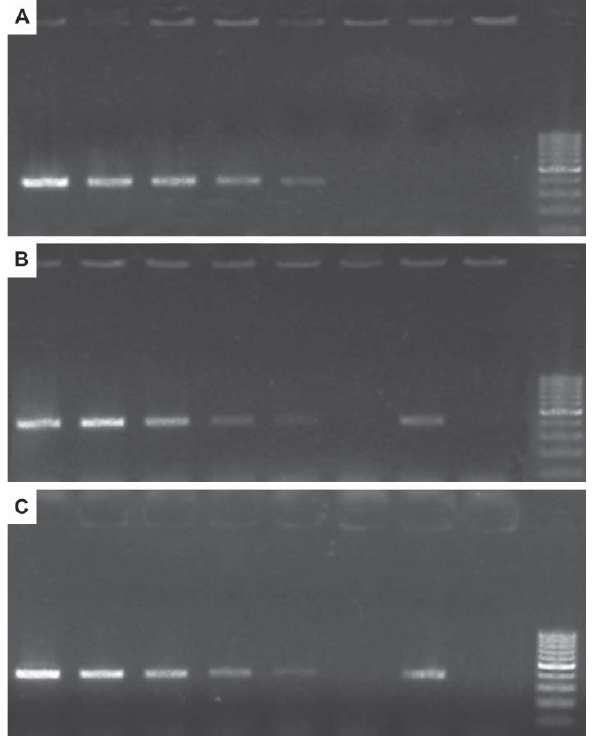
Fig. 1. Primer sensitivity test with (A) pure R. subterra- nea DNA; (B) spiked soil extracts; (C) spiked grapevine root extracts. (A) PCR products of DNA extracts from R. subterranea . From left to right: 1 ng, 100 pg, 10 pg, 1 pg, 100 fg, 10 fg, 1 fg, negative control (a.d.) and DNA ladder. (B) PCR products of DNA extracts from sterile soil spiked with R. subterranea DNA. From left to right: 1 ng, 100 pg, 10 pg, 1 pg, 100 fg, pure soil extract, 1 pg DNA of R. subterranea (positive control), negative control (a.d.) and DNA ladder. (C) PCR products of DNA extracts from grapevine roots spiked with R. subterranea DNA. From left to right: 1 ng, 100 pg, 10 pg, 1 pg, 100 fg, pure root extract, 1 pg DNA of R. subterranea (positive control), negative control (a.d.) and DNA